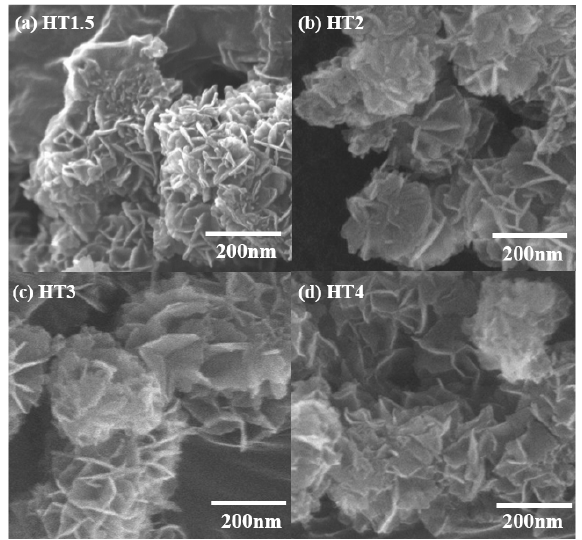
Figure 4. Field emission scanning electron microscopy images (FE-SEM) of the prepared HTX catalysts (X = 1.5, 2, 3, and 4): ( a ) HT1.5, ( b ) HT2, ( c ) HT3, and ( d ) HT4.